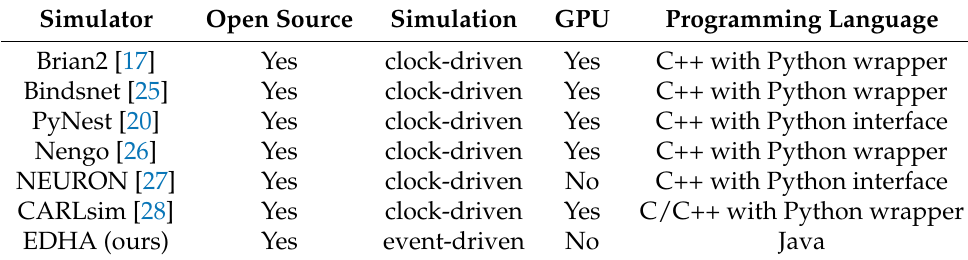
Table 1. Comparison of spiking neural network simulators.